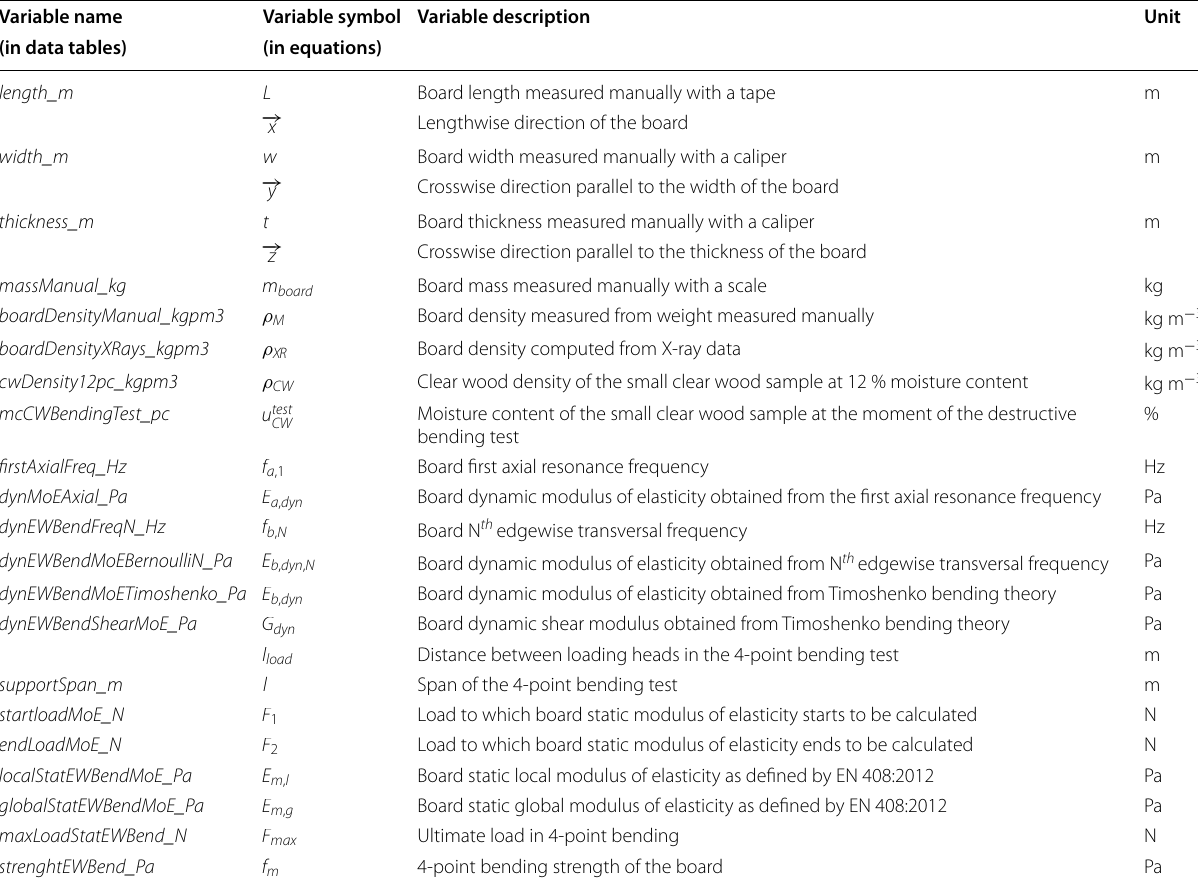
Table 1 List of main symbols and corresponding variable names in data